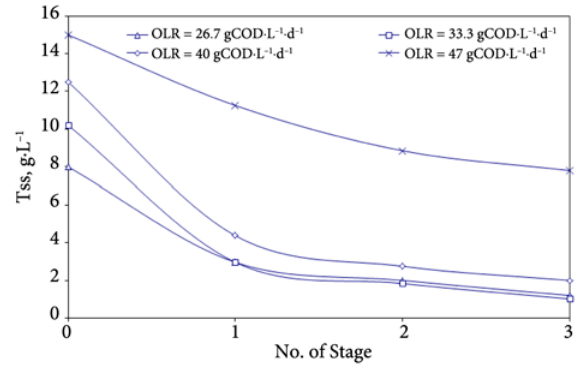
Fig. 4. TSS concentration profiles in different stages of RBC at various OLR